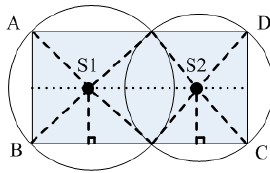
Figure 6. Calculation process for determining the sink wireless range.